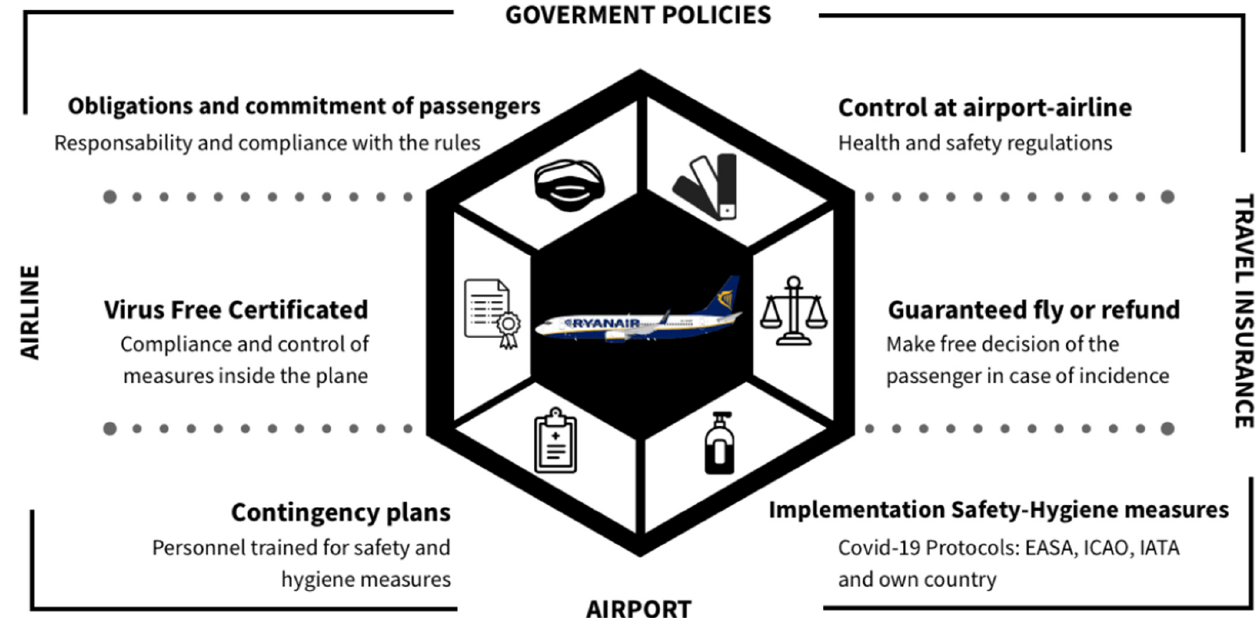
Figure 3. Safety-Hygiene Air Corridor Elements ‘SHACE’. Source. Own elaboration.